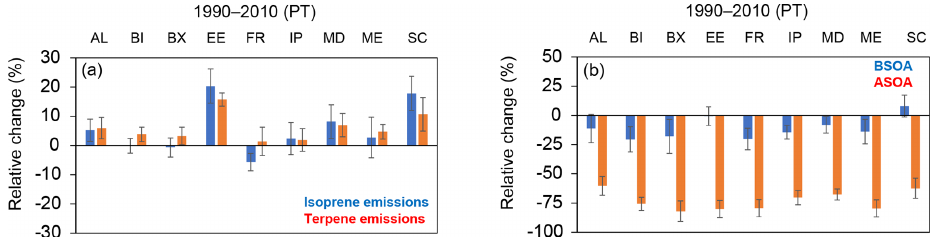
Figure 17. Modeled relative trends for the biogenic emissions (isoprene and terpene, a ) and anthropogenic and biogenic SOA concentra- tions (b) for the different PRUDENCE zones (Fig. 1) for the 1990–2010 (PT) period. The columns show the averages (over land) of all the model estimates and the bars show the standard deviation with respect to the